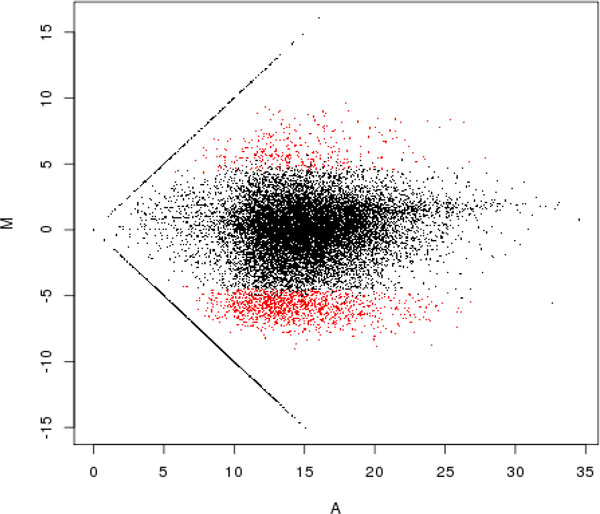
M-A plot of gene expression for female and male flies. Genes up-regulated in females have positive M values. Significantly differentially expressed genes (q-value < 0.05) are shown in red.